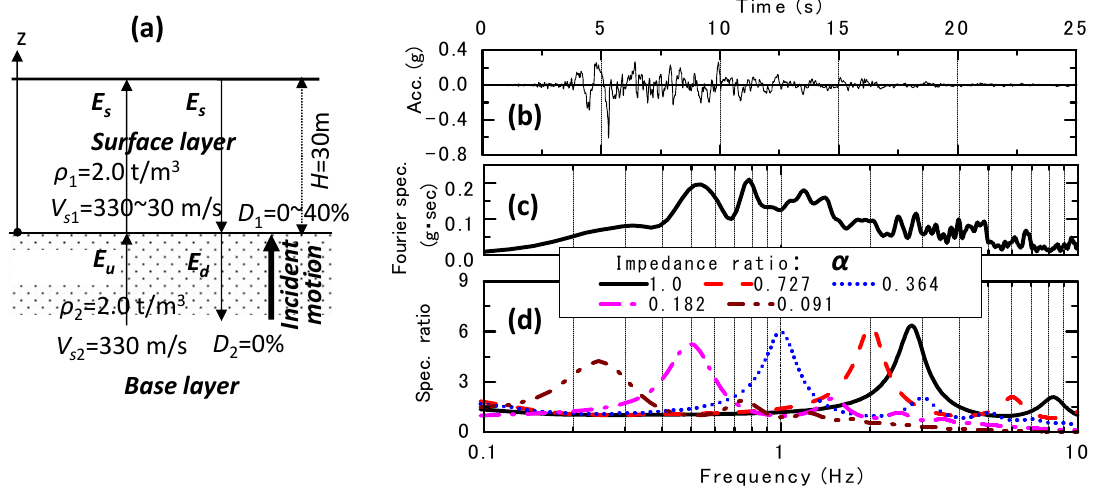
Figure 6. Energy flow for irregular seismic wave: two-layer model ( a ), time–history ( b ), Fourier spectrum ( c ) of input wave, and transfer functions of two-layer model ( d ).